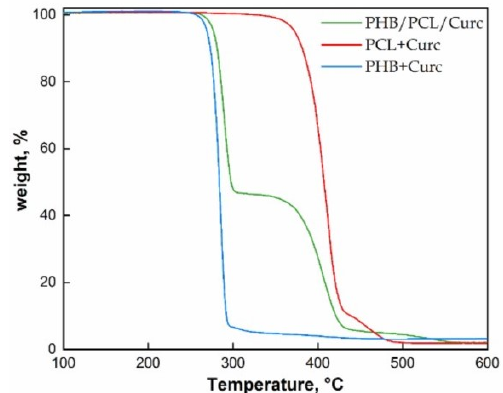
Figure 4. Thermogravimetric analyses (TGA) of electrospun PCL, PHB and PCL/PHB loaded with curcumin.